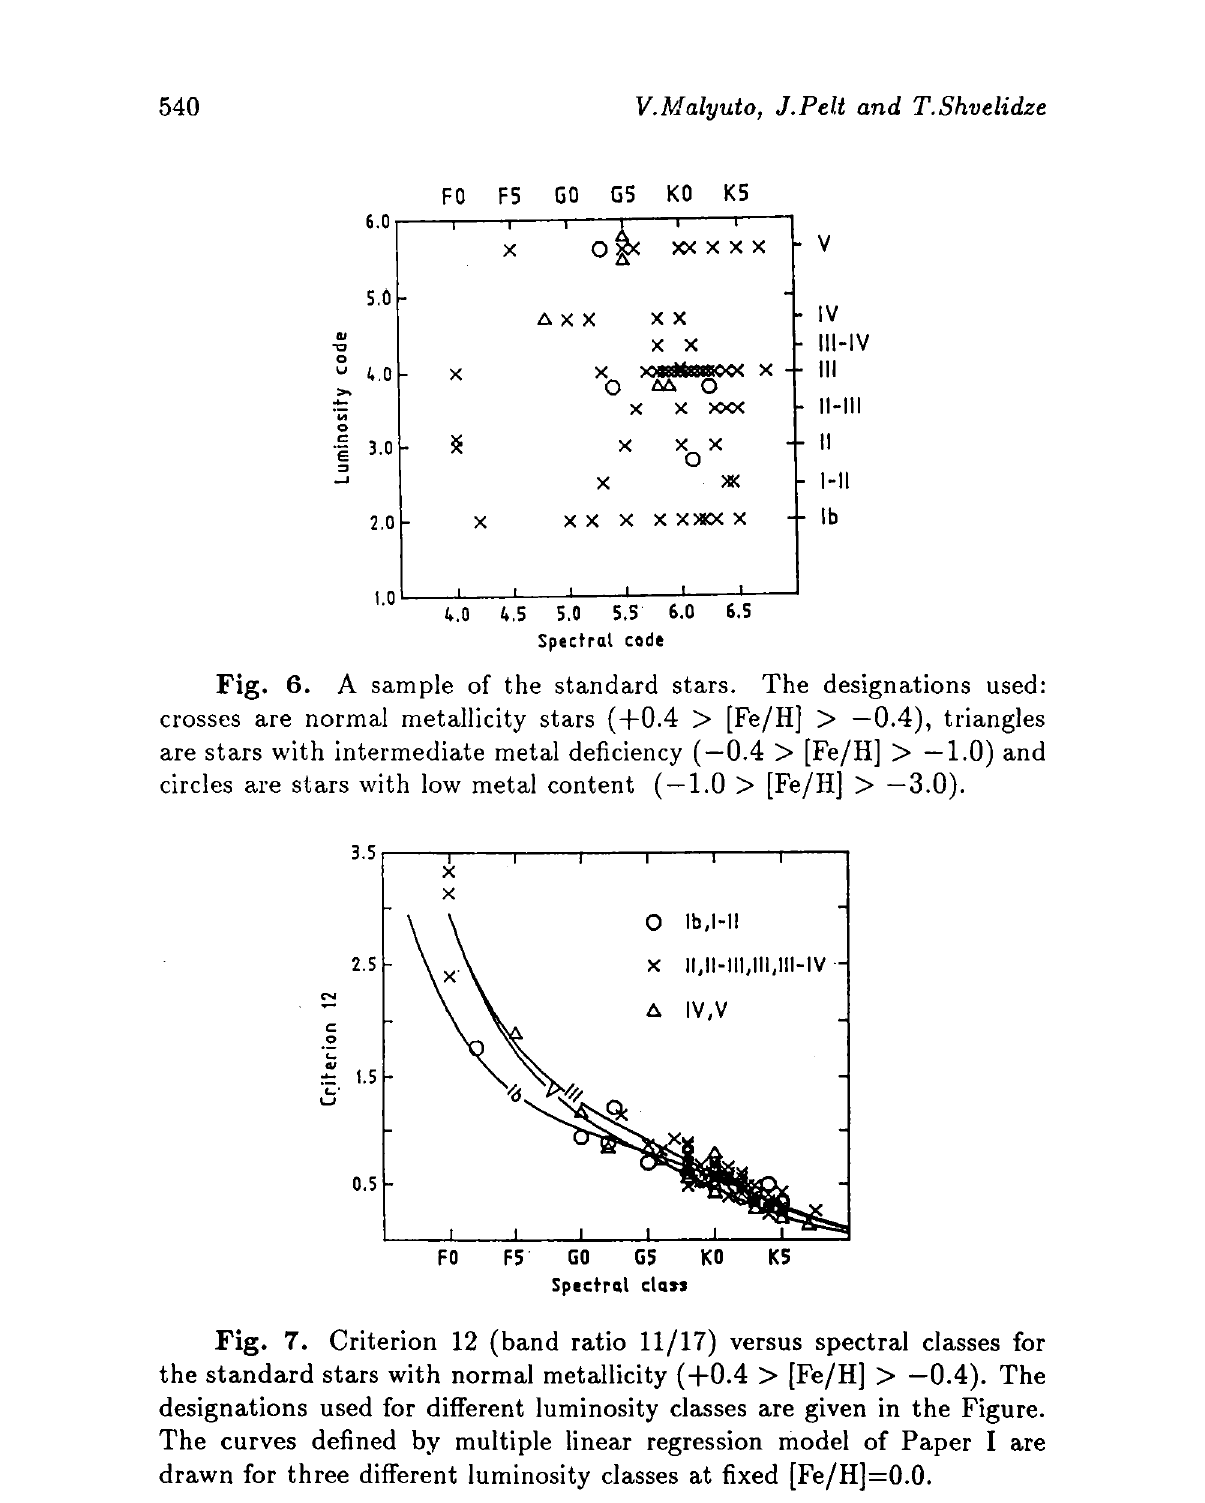
Fig. 7. Criterion 12 (band ratio 11/17) versus spectral classes for the standard stars with normal metallicity ( + 0 .4 > [Fe/H] > - 0 . 4 ). The designations used for different luminosity classes are given in the Figure. The curves defined by multiple linear regression model of Paper I are drawn for three different luminosity classes at fixed